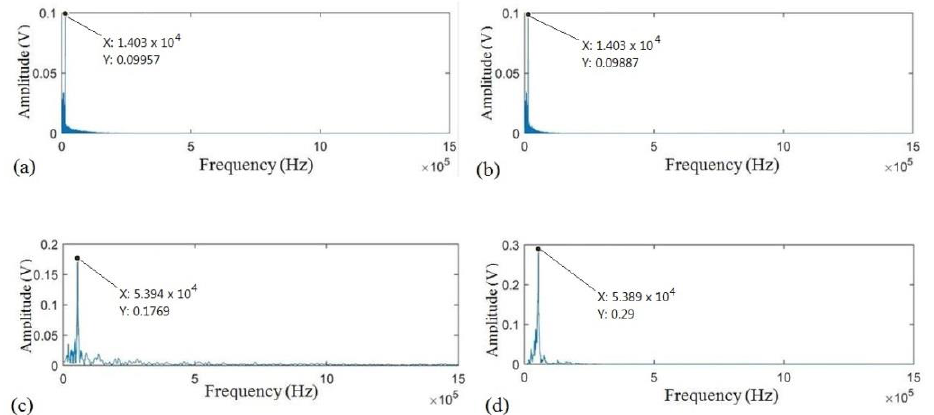
Figure 11. Comparison between simulated signals and measured signals (type 2). ( a ) Simulated broken wire signal, ( b ) Broken wire signal, ( c ) Simulated non-broken wire signal, ( d ) Non-broken wire signal.